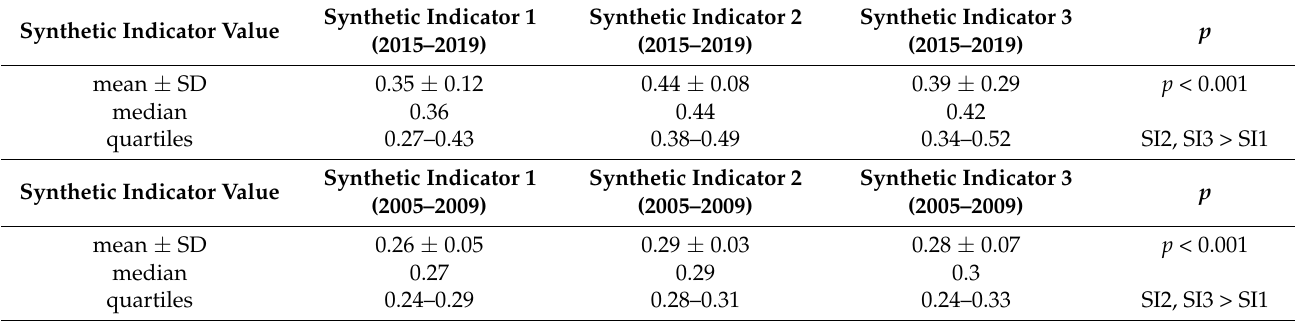
Table 10. Differences in synthetic indicators between 2015–2019 and